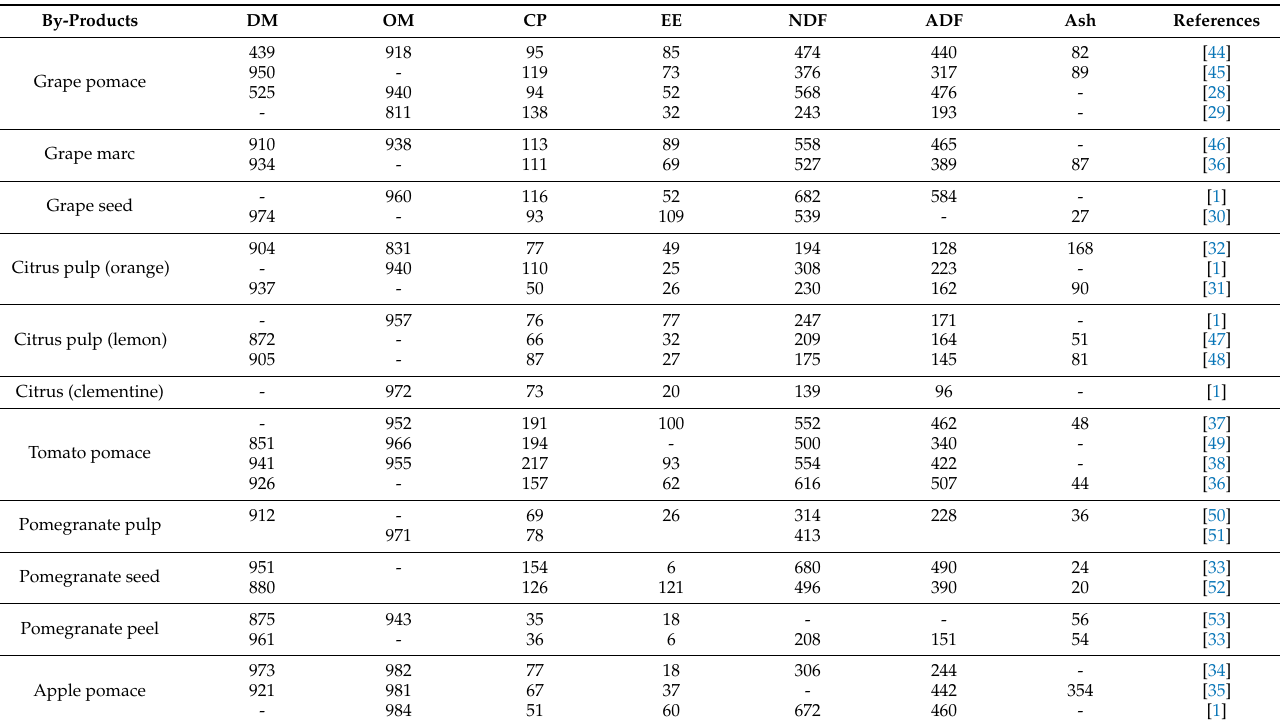
Table 1. Chemical compositions of FVBPs (g/kg of